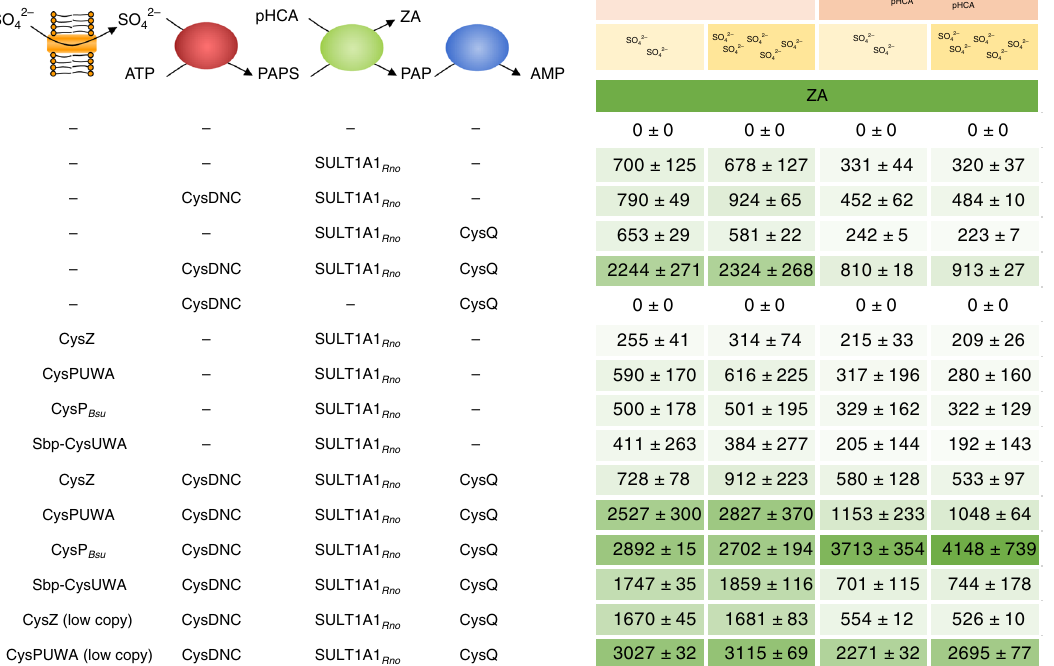
Fig. 4 Improving the supply of activated sulfate promotes production of sulfated products. Strains expressing SULT1A1 Rno from pETDuet-1 alone or with in combination with either an empty pRSFDuet-1 plasmid, a derived plasmid harboring the cysDNC operon, cysQ , a synthetic cysDNCQ operon, various sulfate transport genes or combinations thereof were grown in M9 medium with either low or high concentration of p -coumaric acid (pHCA) and potassium sulfate for 24 h in 96-well plates. Titers ( µ M) of produced zosteric acid (ZA) are shown together with standard deviations (± for n = 3). No production of ZA occurred in the absence of SULT1A1 Rno . Source data are provided as a Source Data fi le Table 1 Transcriptomic response to induction of zosteric acid production Gene